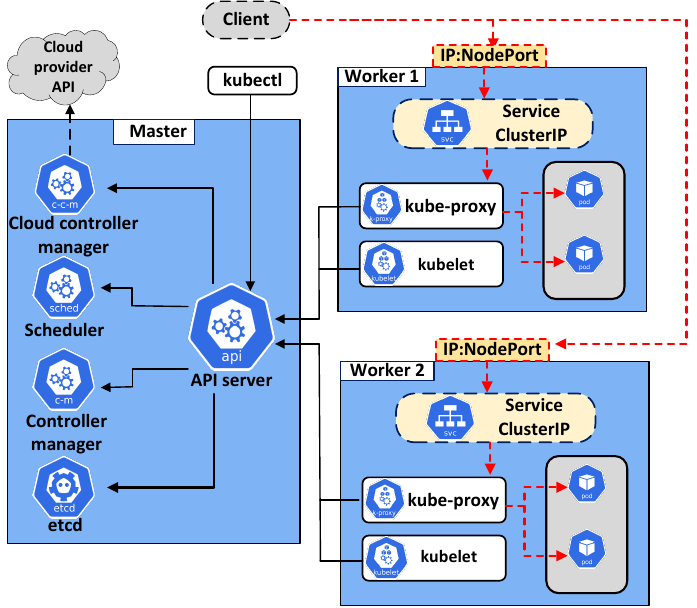
Figure 1. Kubernetes